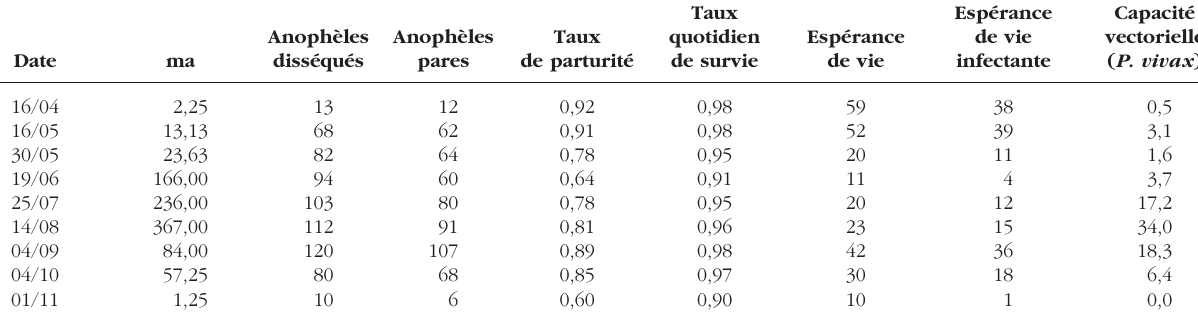
Tableau III. – Variation des paramètres entomologiques impliqués dans l’estimation de la capacité vectorielle d’ An. labranchiae à Larache, 2007.